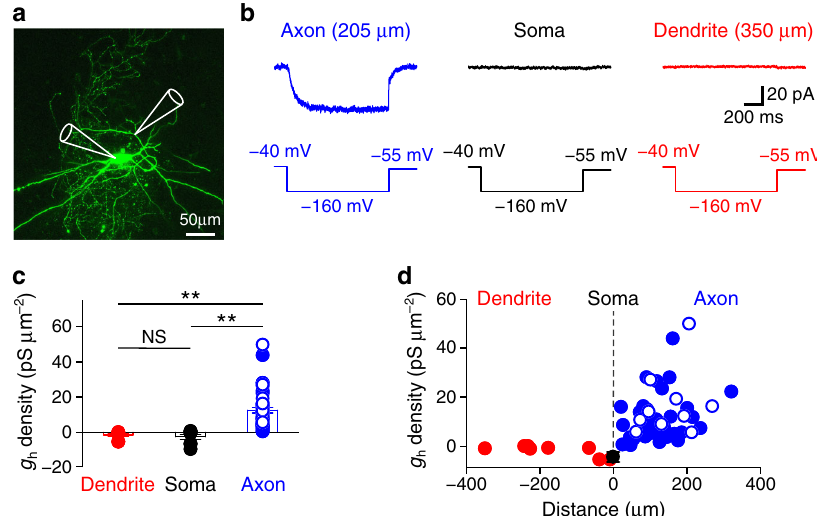
Fig. 1 HCN channels in PV + -BCs are exclusively expressed in axons. a Maximal confocal stack projection of a PV + -BC in the dentate gyrus fi lled with Alexa Fluor 488. Recording pipettes are drawn schematically. Confocal images were acquired for all subcellular recordings ( n = 109 PV + -BCs). b Currents (top) evoked by a hyperpolarizing voltage pulse for activating h-currents (bottom) in outside-out patches excised from either a PV + -BC axon (blue), soma (black), or dendrite (red). c Summary graph of h-conductance density in PV + -BC dendrites ( n = 7 apical and 1 basal dendritic patches), somata ( n = 8 somatic patches), and axons ( n = 48 axonal patches). ** indicates P = 10 − 5 , NS indicates P = 0.71 (two-sided Wilcoxon rank sum test). d Summary plot of h-conductance density in c against distance from the soma. Open blue circles in c and d , data obtained from axon shafts; fi lled blue circles, data obtained from axonal blebs. Error bars in this fi gure represent ± SEM. Source data are provided as a Source data fi